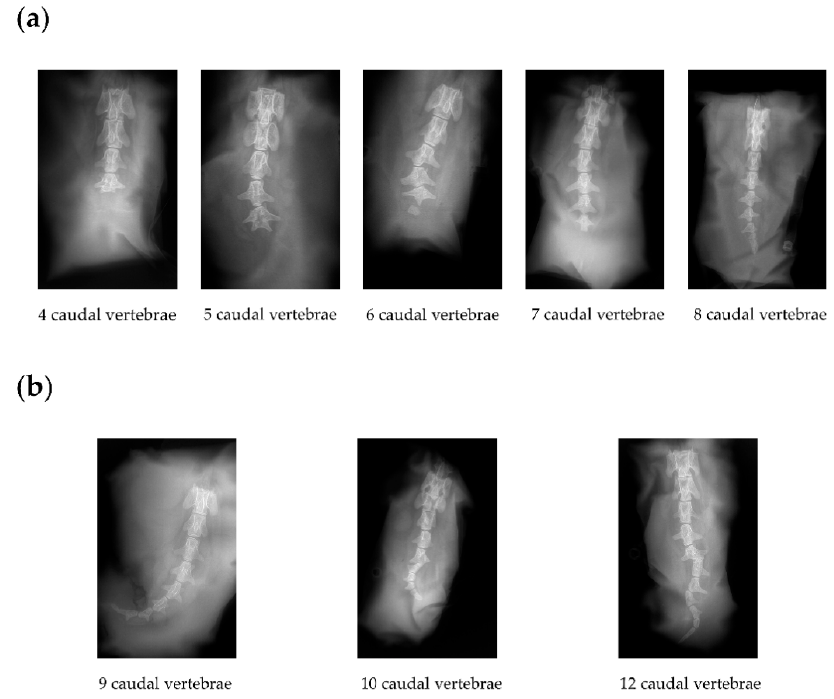
Figure 2. X-ray images of the caudal vertebrae of Barag sheep and short-tailed sheep. ( a ) Representative X-ray images of the caudal vertebrae of short-tailed sheep. ( b ) Representative X-ray images of the three types of caudal vertebrae of Barag sheep. Table 3. Statistics on the number of caudal vertebrae in Barag sheep and short-tailed sheep.